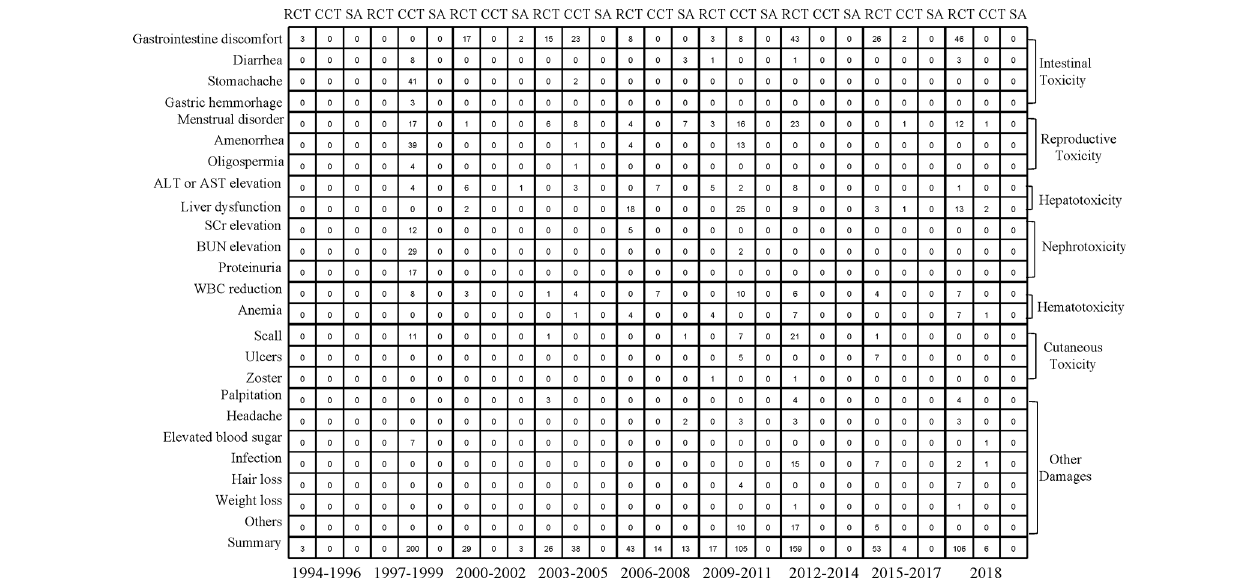
FIGURE 4 | Mapping of seven organ-specific adverse events of study type between 1994 and 2018. RCT , randomized controlled trial; CCT , controlled clinical trial; SA , single-arm